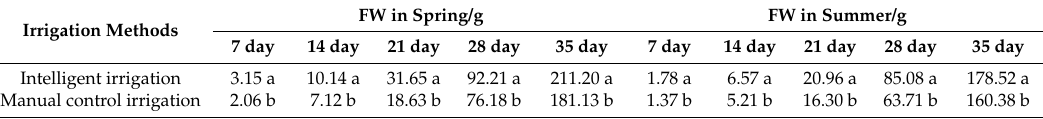
Table 3. The average fresh weight (FW) per plant.